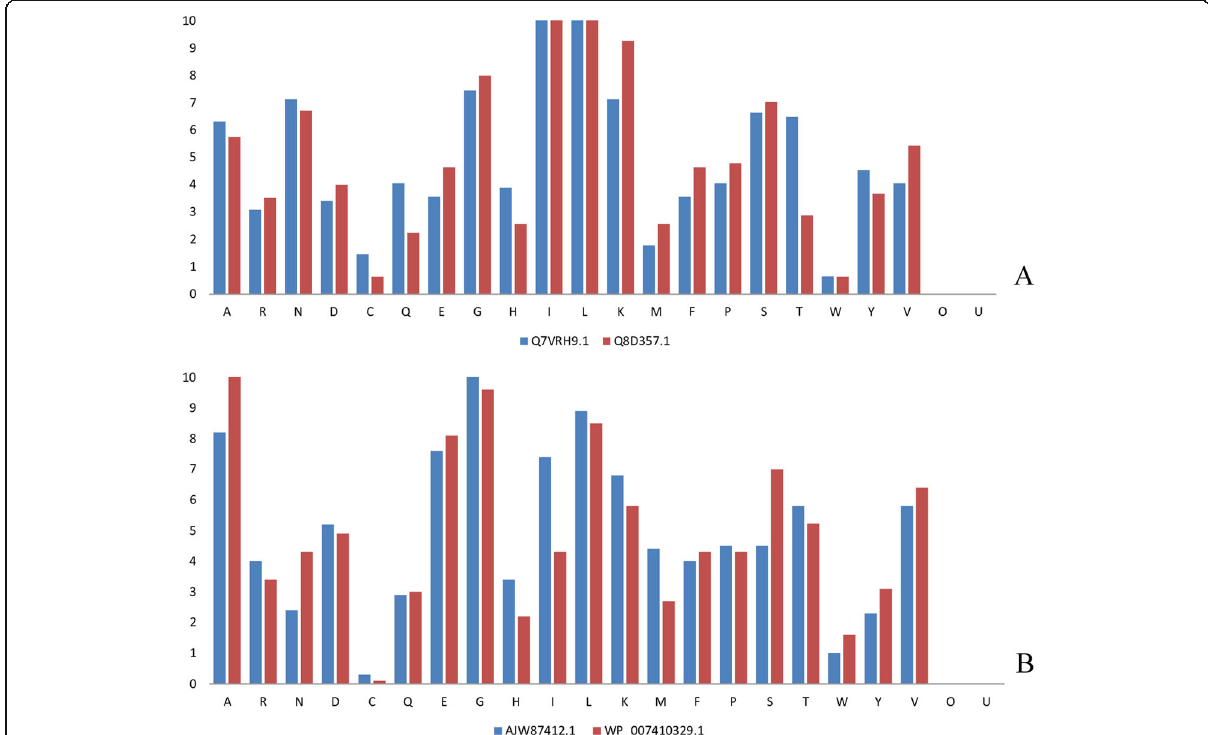
Fig. 4 Variation of residue frequencies between the representative sequences Q7VRH9.1 and Q8D357.1 and AJW87412.1 and WP_007410329.1 of the two datasets, belonging to Enterobacteriaceae and Bacillus species respectively. A substantial variation in the residue percentages is observed for a few residues within and between the two